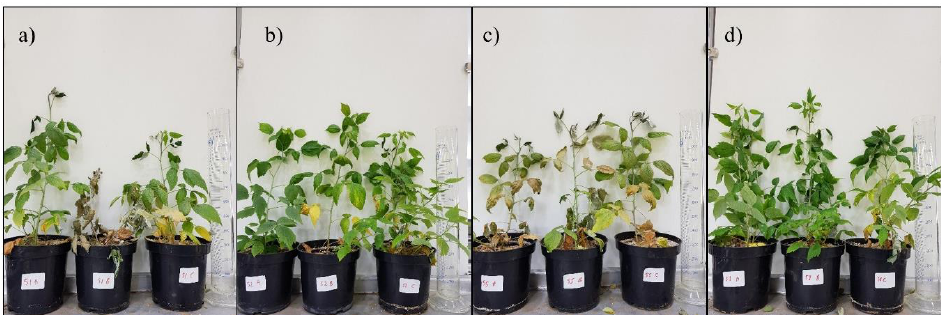
Figure A1. Effect of plant growth stimulation caused by the different naturalization strategies on plants infected with fungal and fungal-like plant pathogens Botrytis cinerea (G277/18), Colletotrichum sp. (G172/18), Phytophthora sp. (G408/18), and Verticillium sp. (G296/18): ( a ) no naturalization strategy, ( b ) naturalization of roots, ( c ) roots naturalization and naturalization watering, ( d ) naturalization watering.